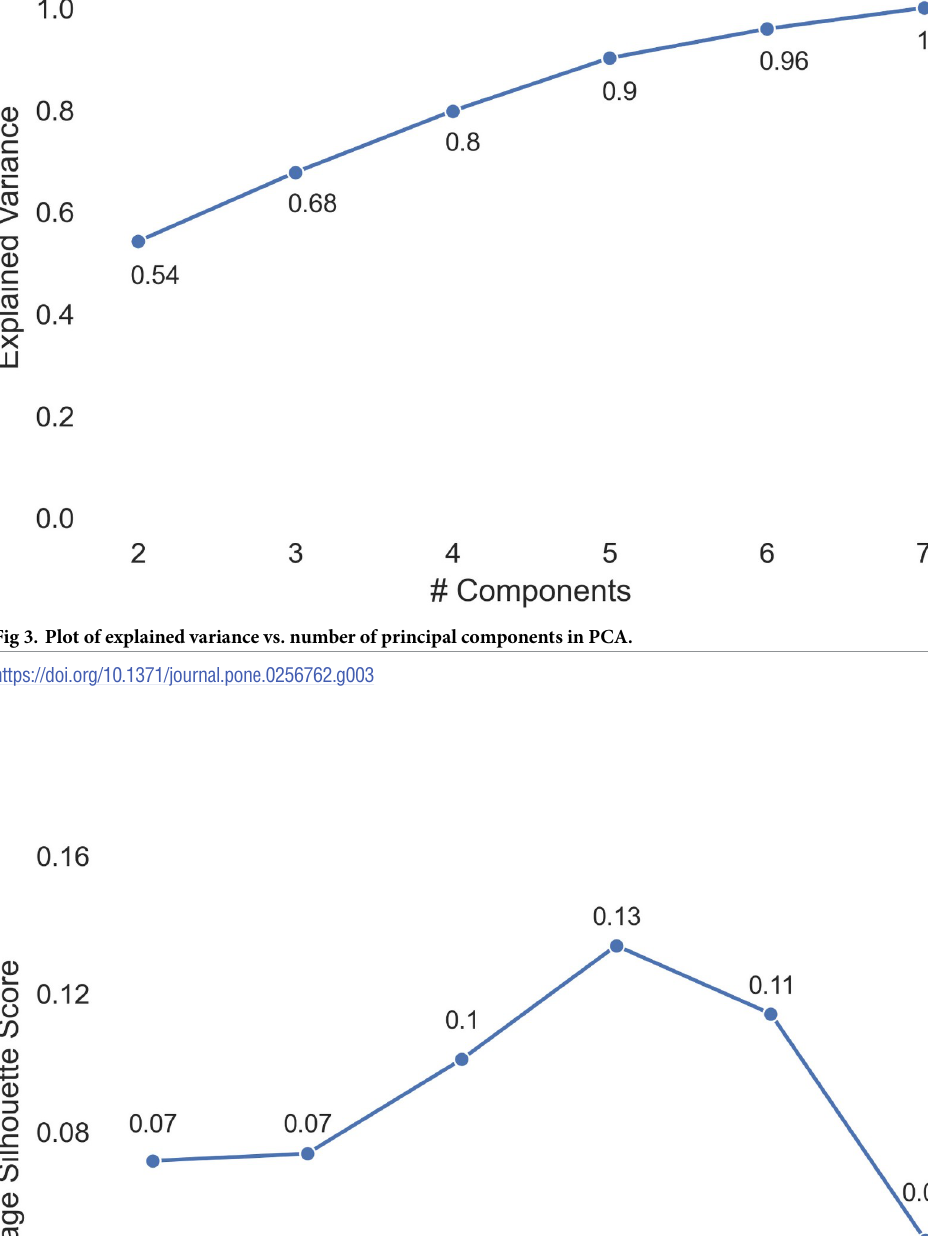
PLOS ONE | https://doi.org/10.1371/journal.pone.0256762 August 27,